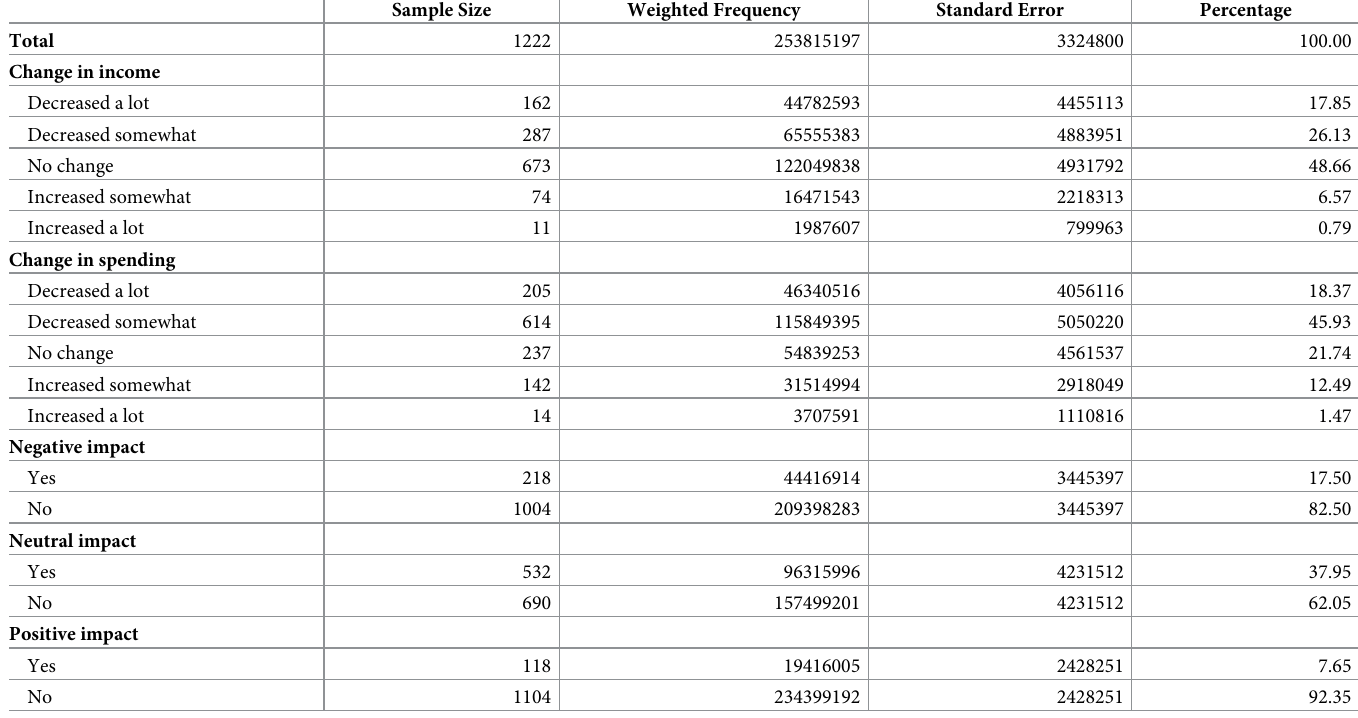
Table 4. Financial impact